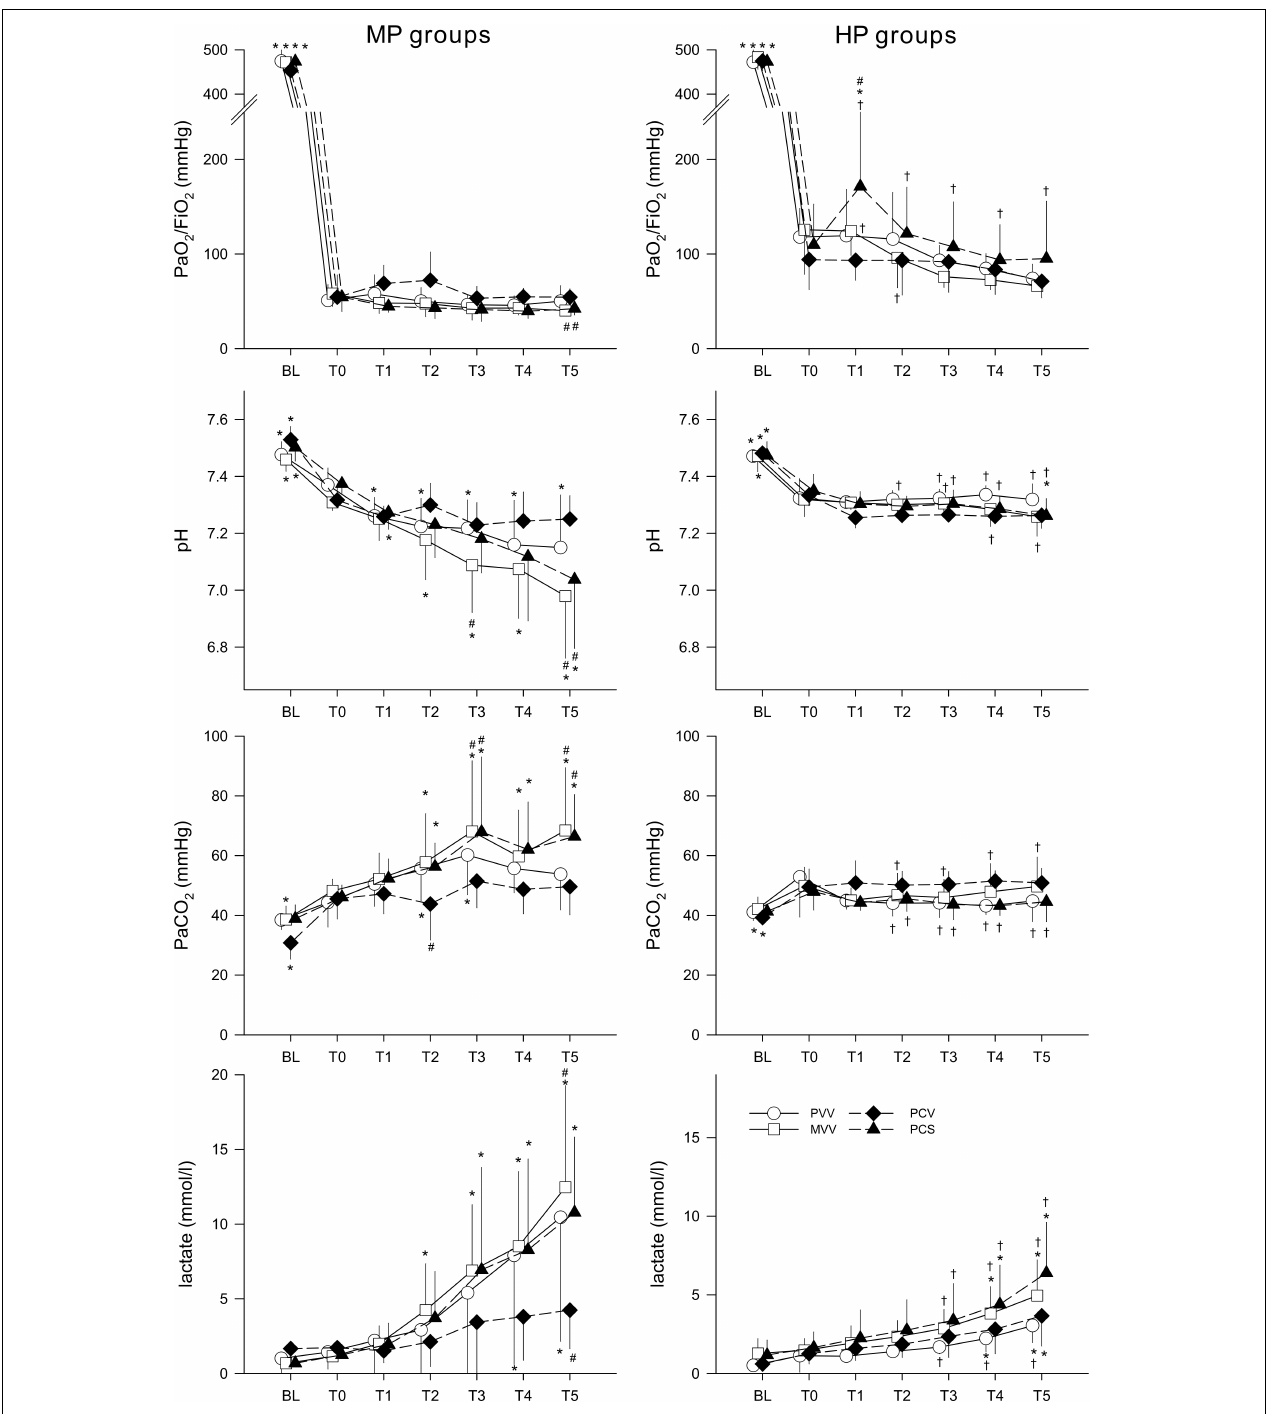
FIGURE 3 | Changes in blood gas parameters before (BL), after the induction of lung injury (T0) and during the application of various ventilation modes. Left panels display changes in groups ventilated with a PEEP of 6 cmH 2 O, whereas groups depicted in the right panels were ventilated with a PEEP of 9 cmH 2 O. Data are presented as group means ± half-width of 95% confidence interval. PaO 2 , arterial partial oxygen pressure. FiO 2 , fraction of inspired oxygen. PaCO 2 , arterial partial carbon-dioxide pressure. T1–T5, measurement points at the end of each 5 h of ventilation with an experimental pattern. MP, moderate PEEP. HP, high PEEP. PVV, physiological variable ventilation. MVV, mathematical variable ventilation. PCV, pressure-controlled ventilation. PCS, pressure-controlled ventilation with regular sighs. Results of the ANOVA analyses ( p -values) for factor “ventilation mode.” p < 0.01 for pH, lactate and PaCO 2 , p = 0.12 for PaO 2 /FiO 2 ; for factor “PEEP.” p < 0.01 for all variables; for the interaction of “ventilation mode ∗ PEEP”: p < 0.01 for pH, PaCO 2 , and PaO 2 /FiO2, p = 0.25 for lactate; for interaction of “ventilation mode ∗ PEEP ∗ time”: p < 0.01 for all variables. ∗ p < 0.05 vs. T0. # p < 0.05 vs. PVV. † p < 0.05 vs. MP.